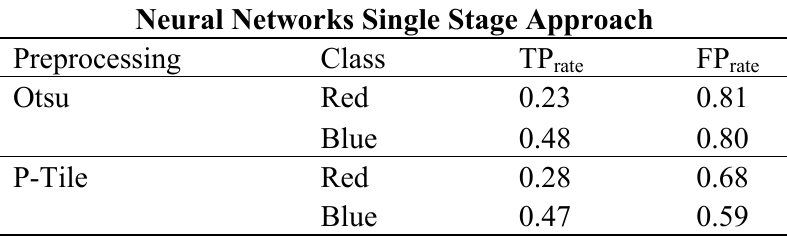
Table 4. Results of the SSNN approach for recognition.